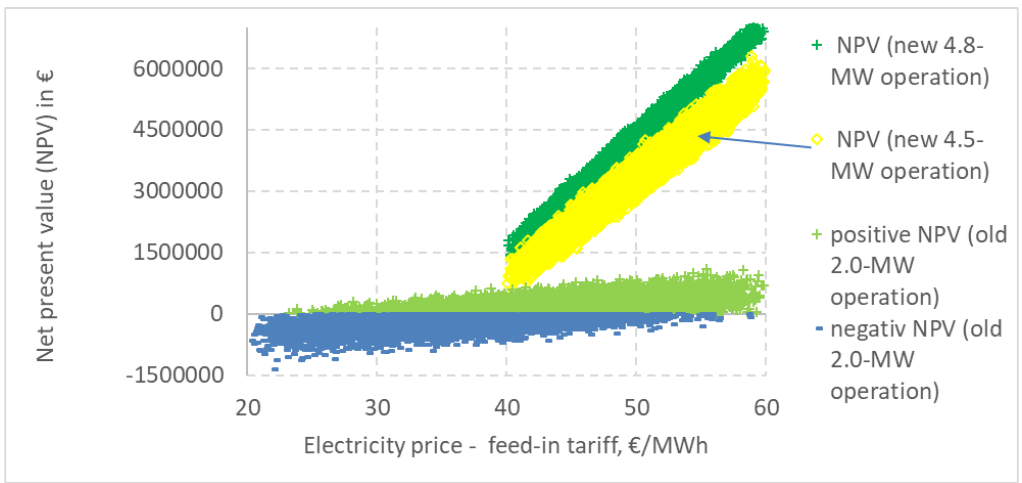
Figure 10. Net present value (NPV), depending on the feed-in tariff and other influencing parameters (see Table 4); stochastic simulation with 10,000 repetitions with @RISK. Source: own calculations.